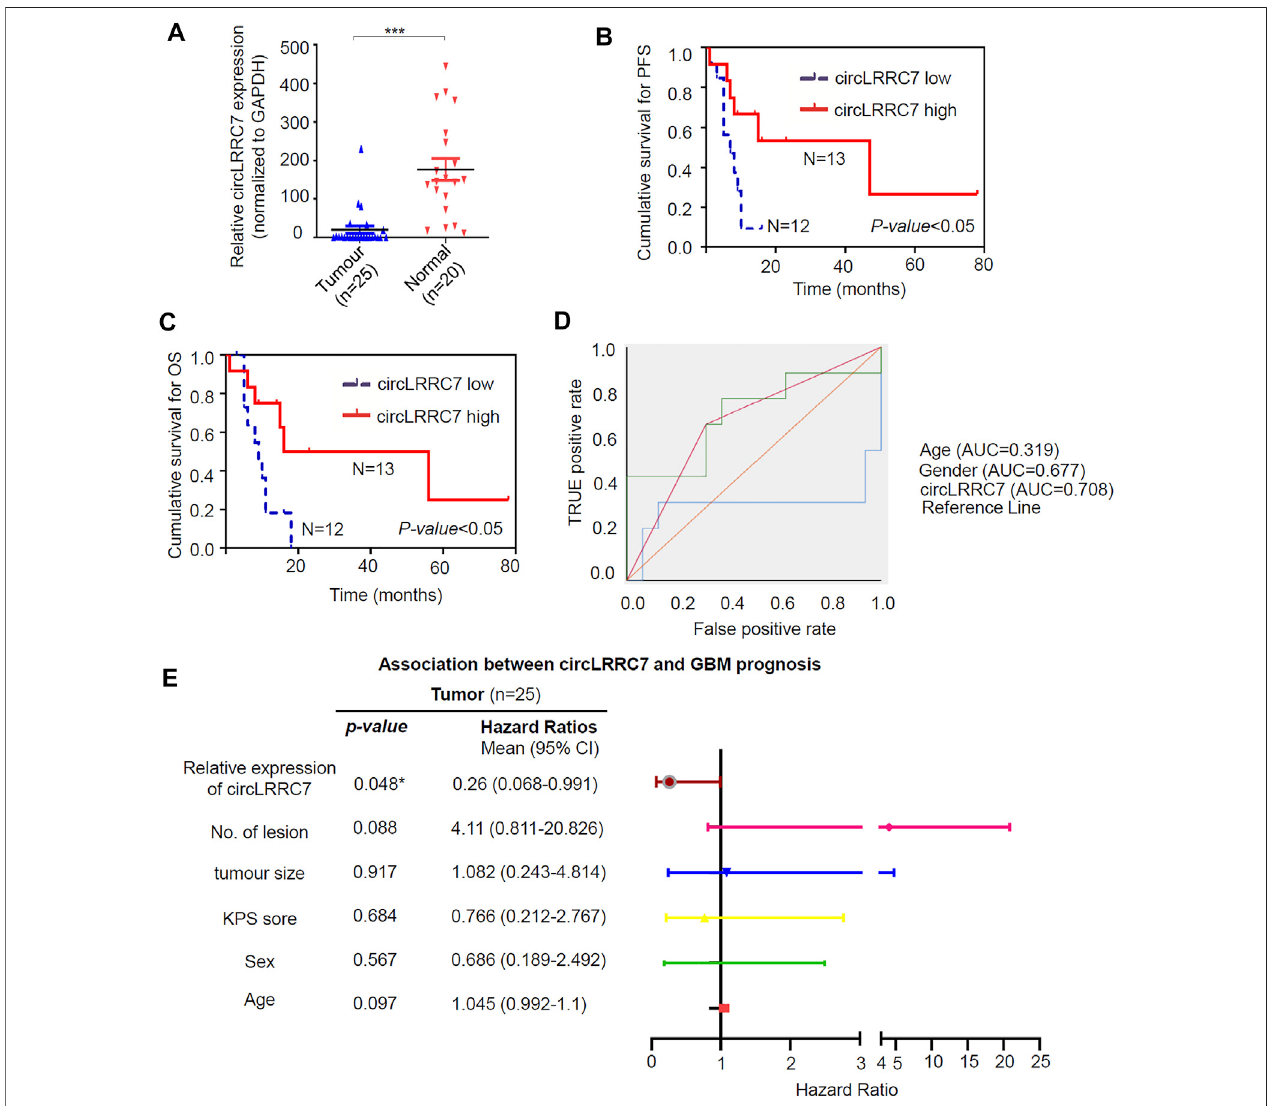
FIGURE 2 | Validation of circLRRC7 as an independent prognostic predictor of GBM. (A) The relative expression of circLRRC7 in 20 normal brain tissues and 25 GBM tissues. (B,C) Kaplan-Meier PFS (B) and OS (C) curves of GBM patients in correlation with circLRRC7 expression. (D) ROC to predict prognosis based on clinicopathology characters. Only circLRRC7 expression showed diagnostic discriminatory value as the area under the ROC curve (AUC) was 0.708 (E) Forest map indicatedthatcon fi denceinterval(CI) ofcircLRRC7 was < 1,but CIofnumberoflesions,tumoursize,KPSscore,sexandage stretchedacross1.(* p < 0.05;*** p <